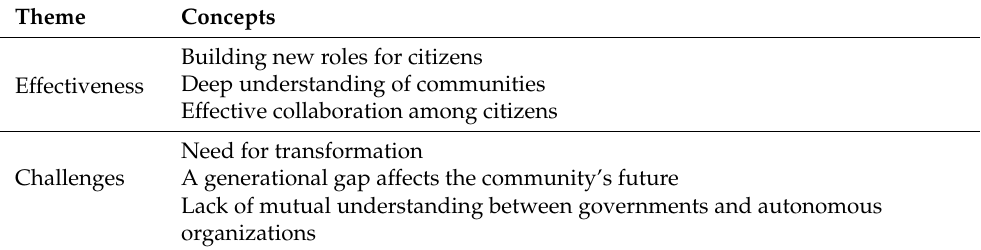
Table 3. The results of thematic analysis regarding the effectiveness and challenges of multifunctional